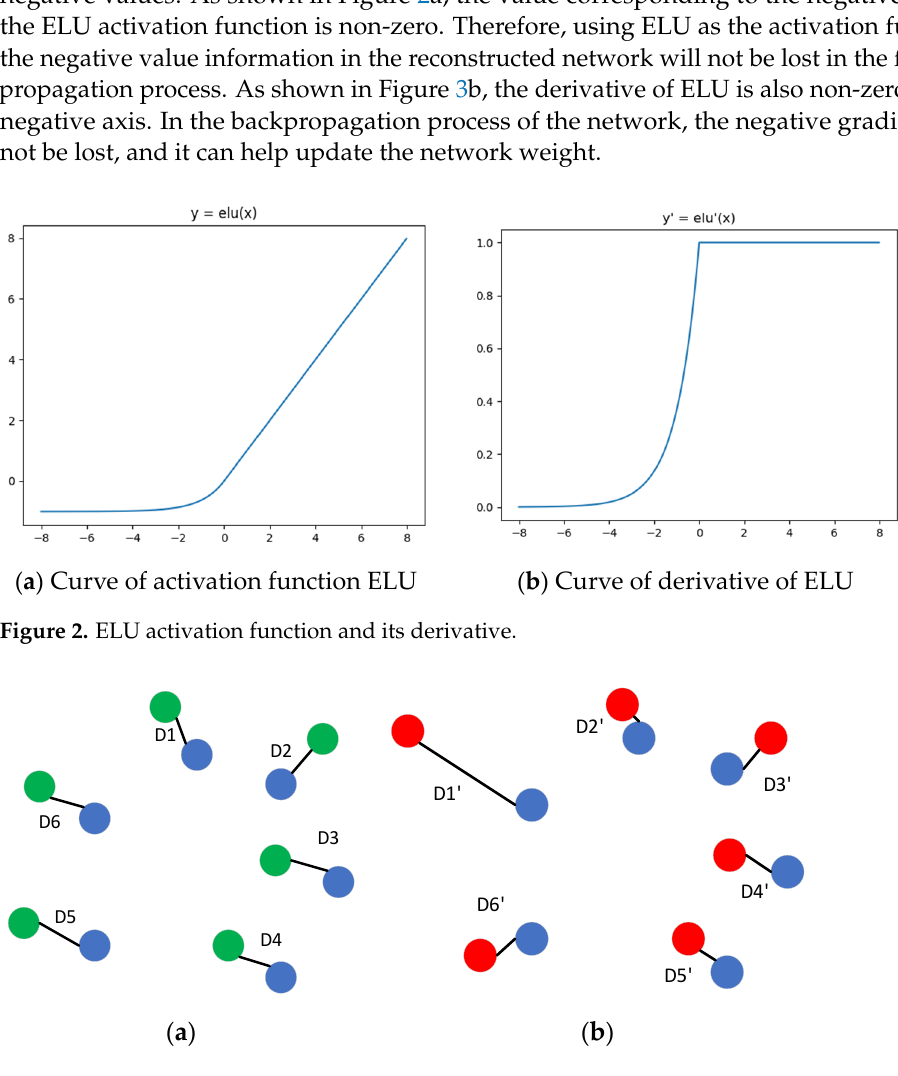
Figure 3. Different reconstructions with the same CD loss